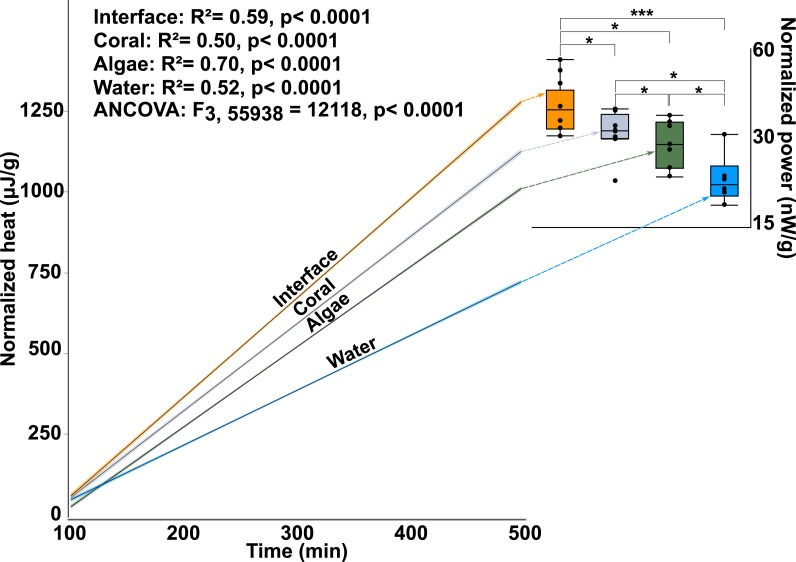
Microbial power output.The y-axis is the total heat (µJ, microjoules per g, gram seawater). The x-axis is time in minutes, min. The lines represent the best fit for the mean of the eight replicates. The inset shows total power output of microbial communities (nW/g, nanowatts per gram). The power output represents the first derivative of the lines in the main figure. (∗∗∗
T-test, p ≤ 0.001 ∗
T-test, p ≤ 0.05).